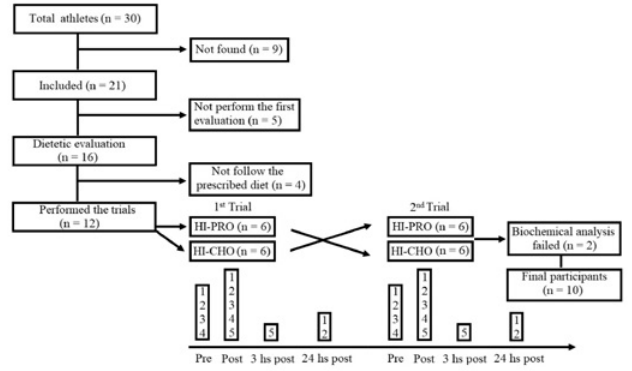
Figure 1. Chart and time line of experimental procedures. 1. Blood sample, 2. Perceived pain and recuperation, 3. Perceived exertion, 4. Heart rate and, 5.